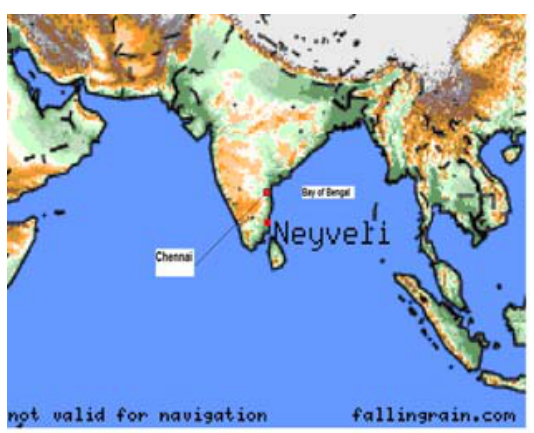
Fig. 1. Location of NLC (Latitude -11° 32' -1" N, Longitude - 79° 29' -1" E).